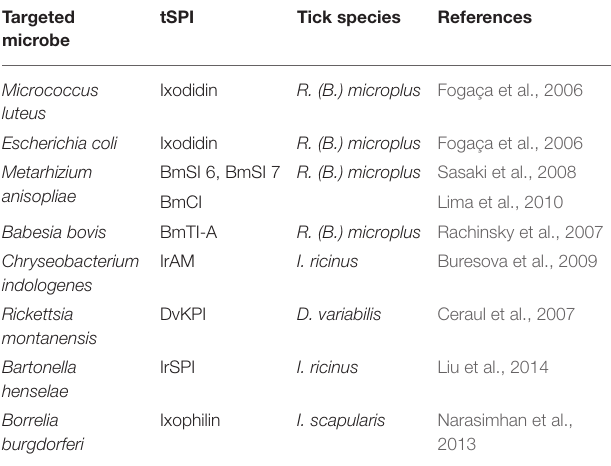
TABLE 2 | Antimicrobial activities of serine protease inhibitors of ticks (tSPI). Targeted